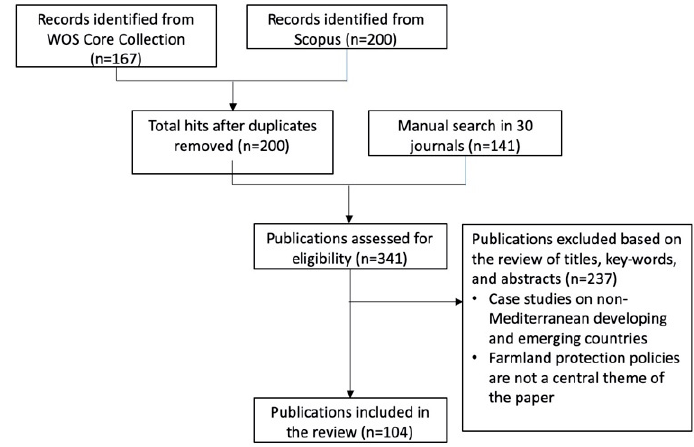
Figure 1. Flow diagram of the selection process.